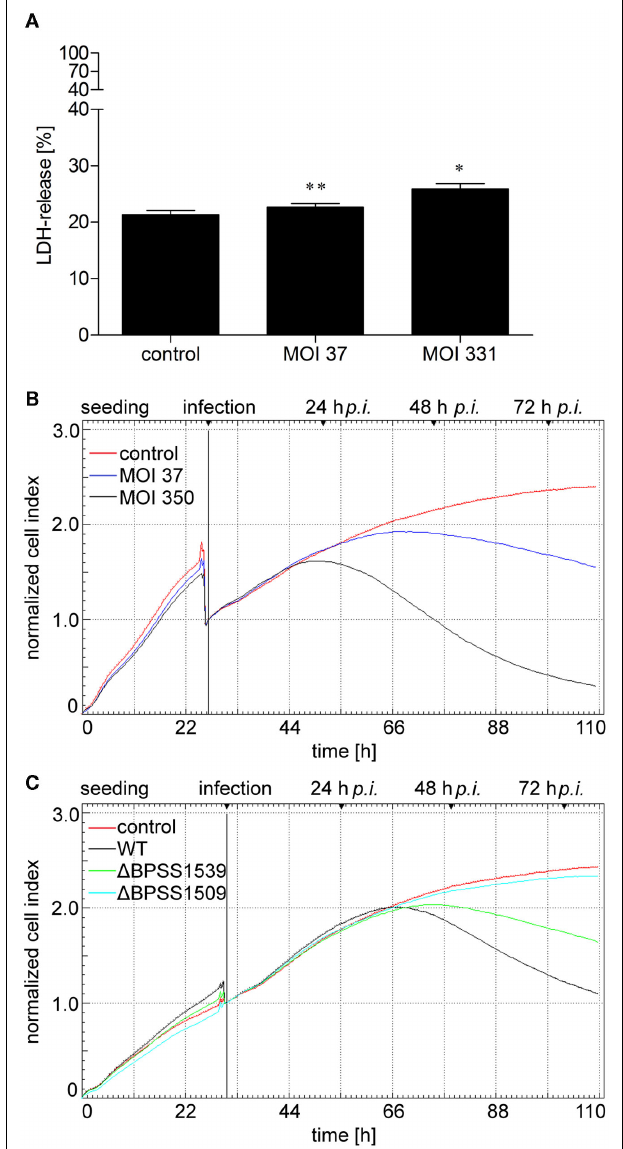
FIGURE 3 | Burkholderia pseudomallei infection leads to cell damage of hepatocytes. (A) HepG2 cells were infected with B. pseudomallei E8 at multiplicities of infection of 37:1 and 331:1, respectively, and lactate dehydrogenase (LDH) release was determined 24h after infection.Values are expressed as percentages relative to the LDH activity in supernatants from the 100% lysis control. Data are presented as mean with SEM of triplicate determinations. One representative experiment out of three independent experiments is shown. Statistical analyses were performed using a Student’s t -test (* p < 0.05, ** p < 0.01). (B,C) HepG2 cells were seeded on 96 well E-plates and continuously monitored using the xCELLigence system. At the indicated time point, cells were infected with (B) B. pseudomallei at MOI of 37:1 and 350:1, respectively, or (C) B. pseudomallei wild-type (WT),T3SS-3 mutant Δ BPSS1539, orT6SS-1 mutant Δ BPSS1509 at MOI of ∼ 400:1, and cell response was monitored every 30min by impedance measurement. One representative experiment out of three independent experiments is